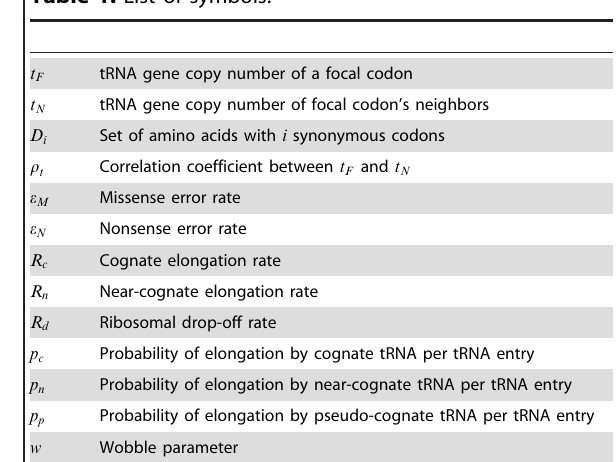
Table 1. List of